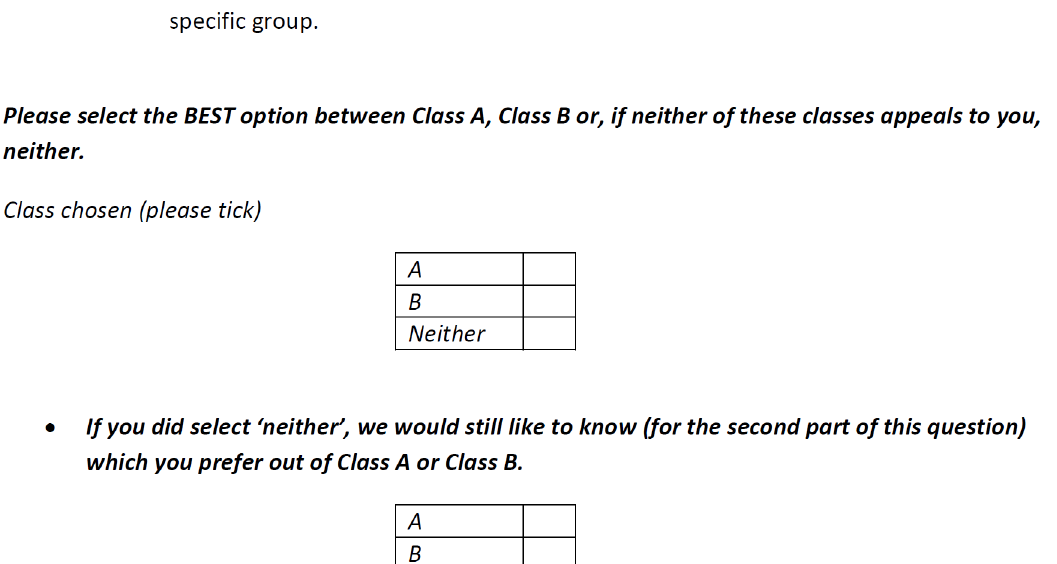
The model was estimated using panel mixed multinomial logit methods using NLOGIT 4.0. The dependent variable was the choice of the participants with a higher utility indicating a preference to attend a class compared with no class and choose one class over another. All attribute levels were effects coded with the cost variable specified as a constrained triangular distribution and the culture and transport variables specified as uniform distributions to reflect the binary nature of the attributes. A constant term was included to capture the preference of choosing a class over no class and this was specified as having a normal distribution. A panel specification was used to account for correlated choices within an individual. Limited sociode- mographic information was able to be collected about participants including their age, body mass index (BMI), gender and who they lived with. The model was based on the attributes pre- sented and interaction terms between all attributes with sociodemographic information